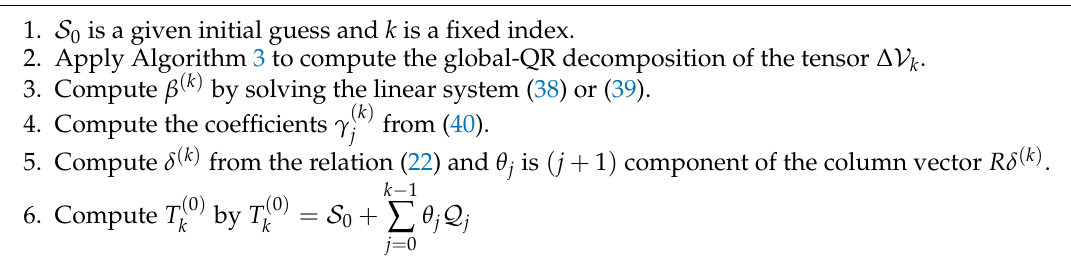
Algorithm 4 Implementation of TG-MPE/TG-RRE via the global-QR